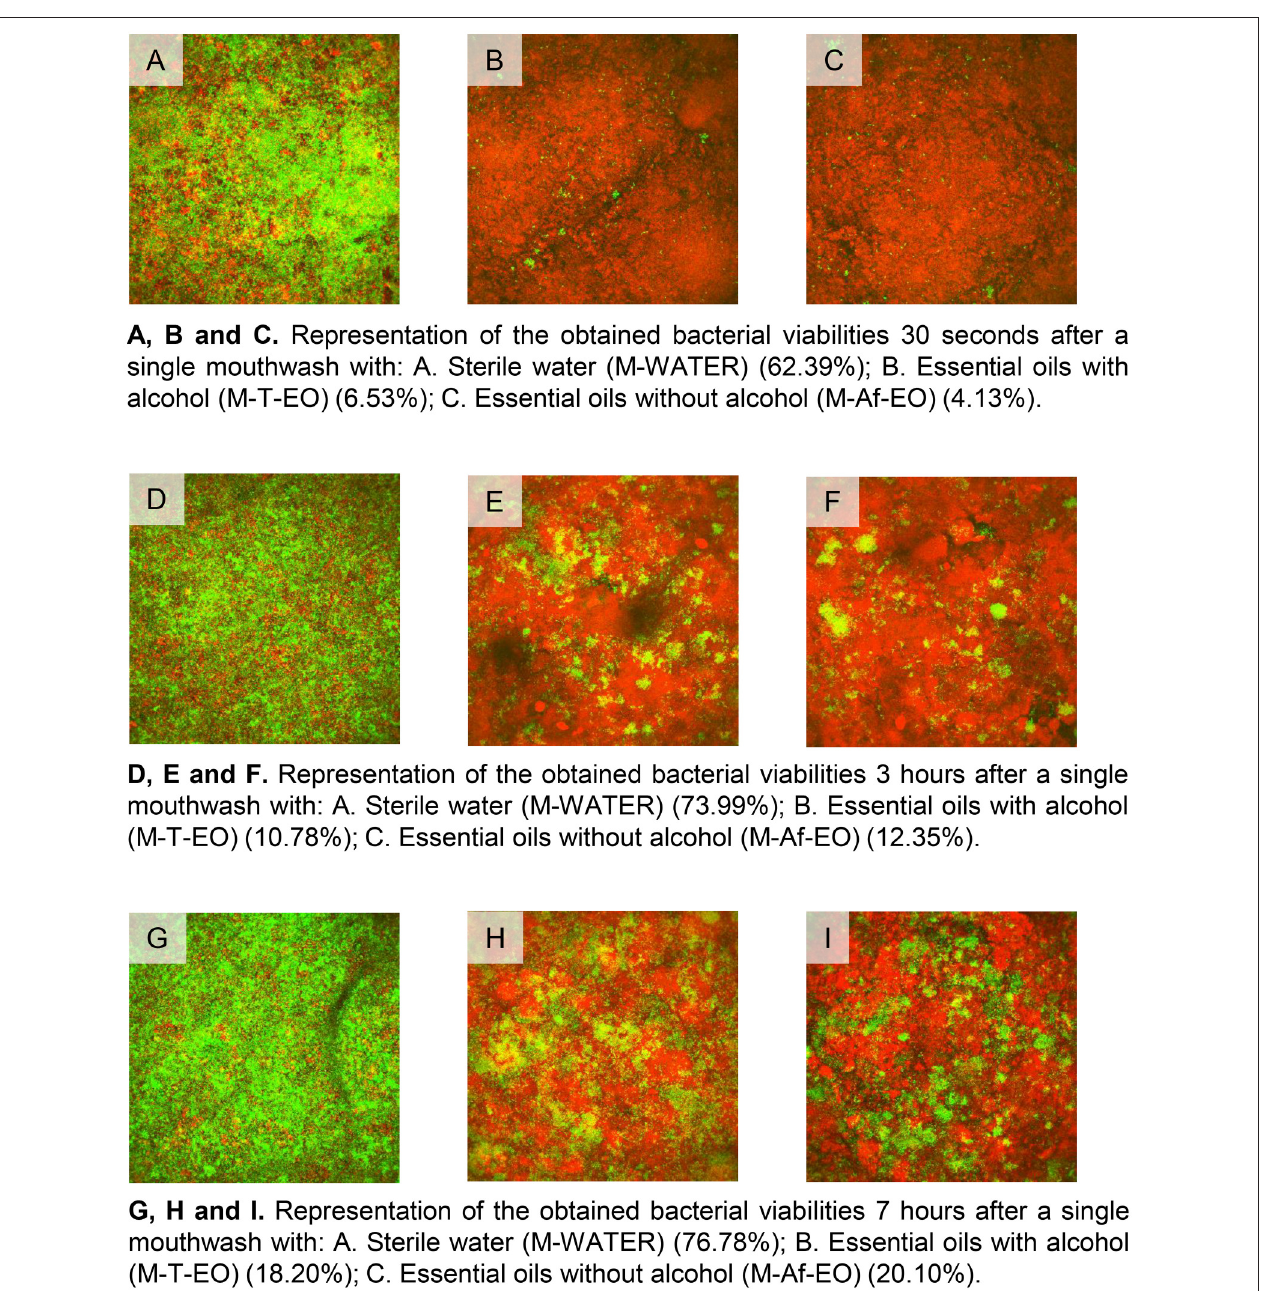
FIGURE 3 | Representative images of the obtained bacterial viabilities at 30s, 3 and 7h after a single mouthwash with sterile water (M-WATER), traditional essential oils (M-T-EO), and alcohol-free essential oils (M-Af-EO).